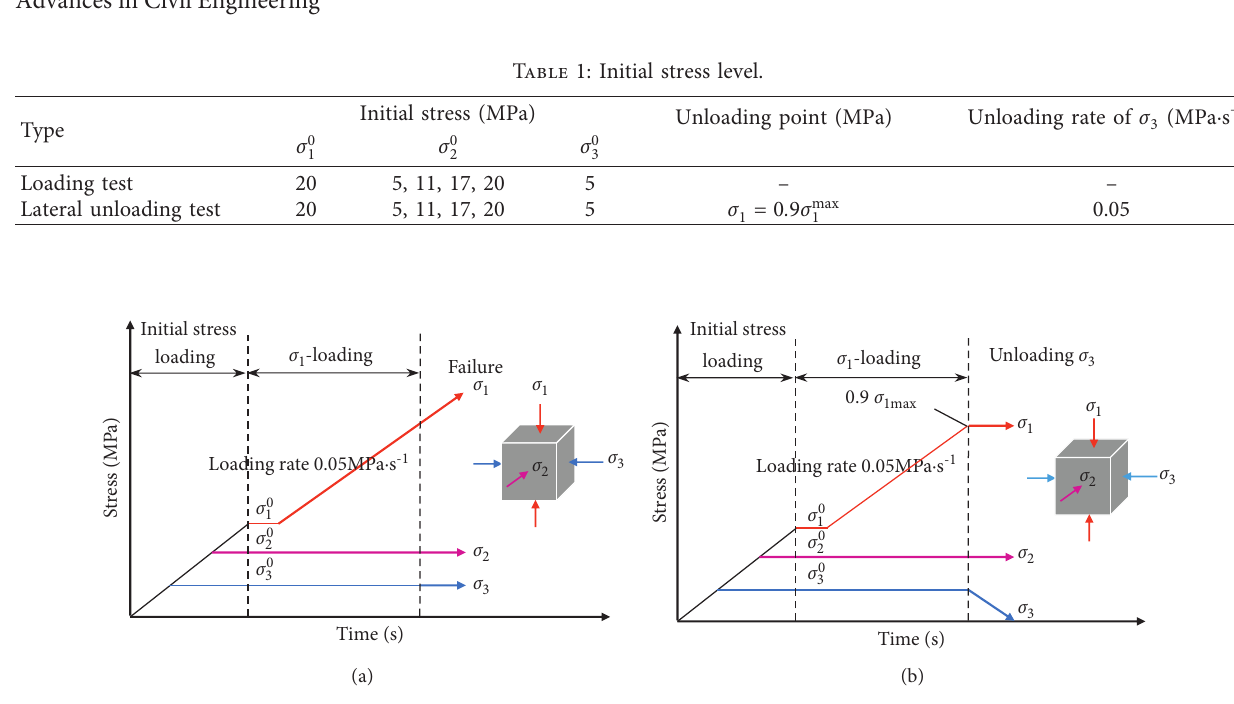
Figure 2: Stress path schematic diagram of the (a) true triaxial loading test and (b) true triaxial lateral unloading